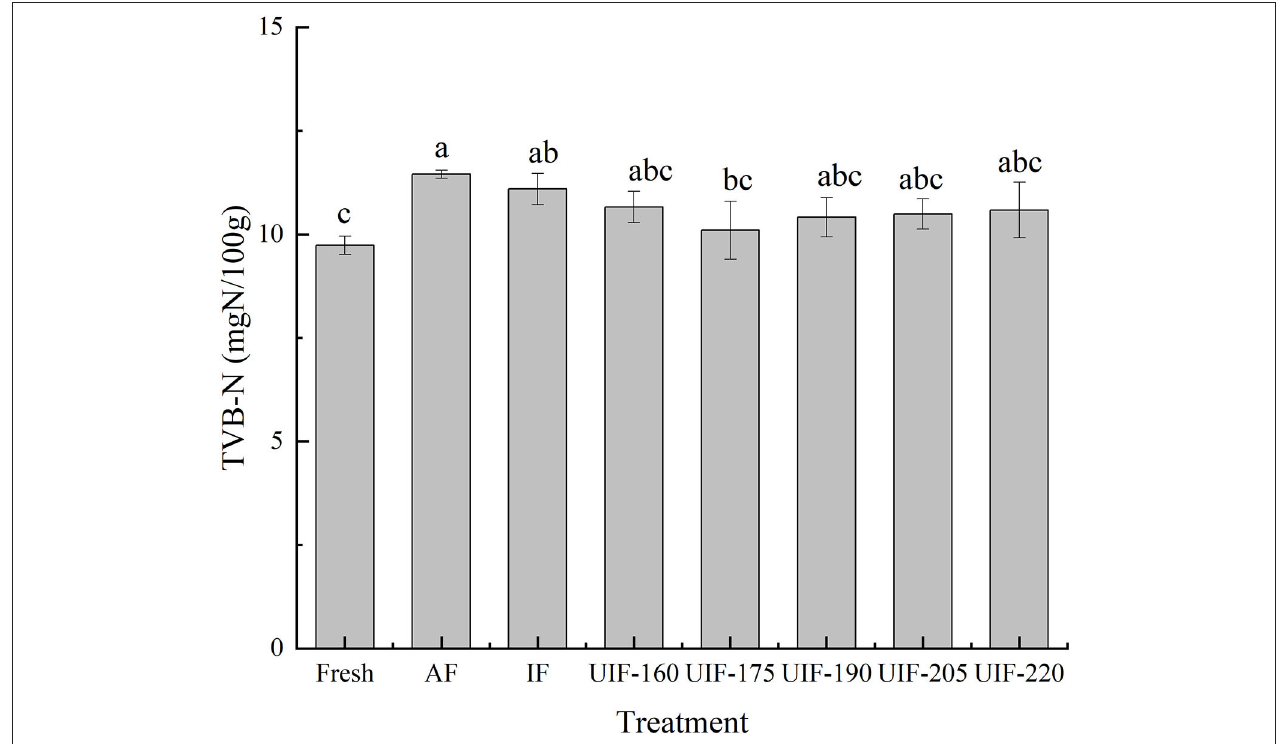
FIGURE 8 | Influence of different freezing treatments on the TVB-N of the large yellow croaker. The results are average ± standard deviation ( n = 3).